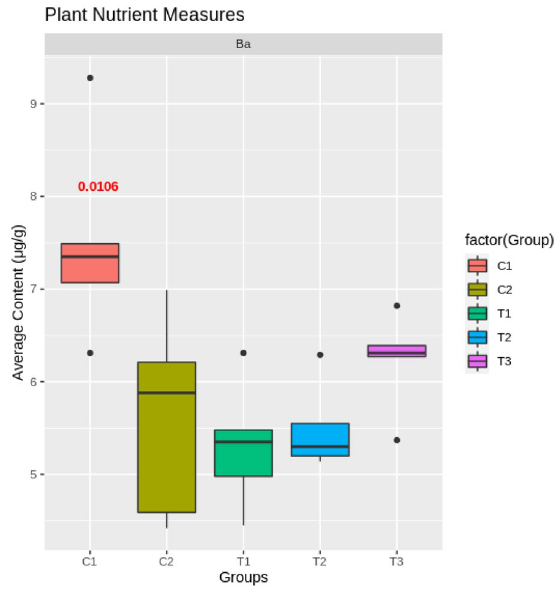
Figure 13. Test-bed distribution of average content of Ba[1] ( µ g/g) as a function of the treatment group (T1– T3) or control group (C1, C2).